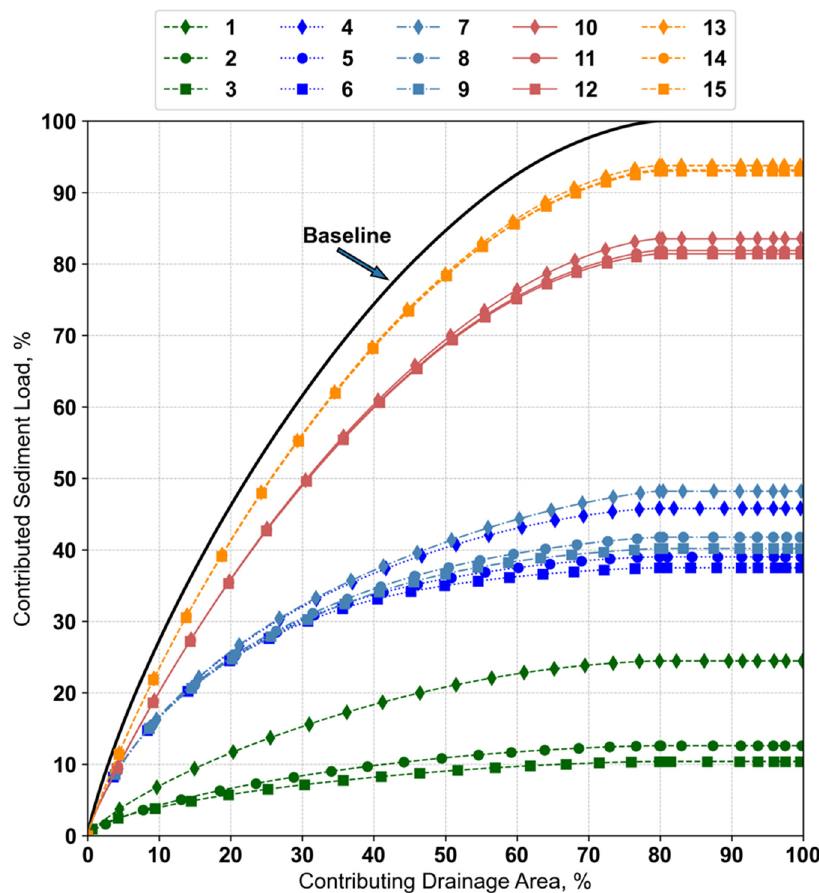
Figure 13. Ranked ratio analysis between accumulated sub-catchment annual average sediment yield per unit area and their corresponding accumulated drainage area.